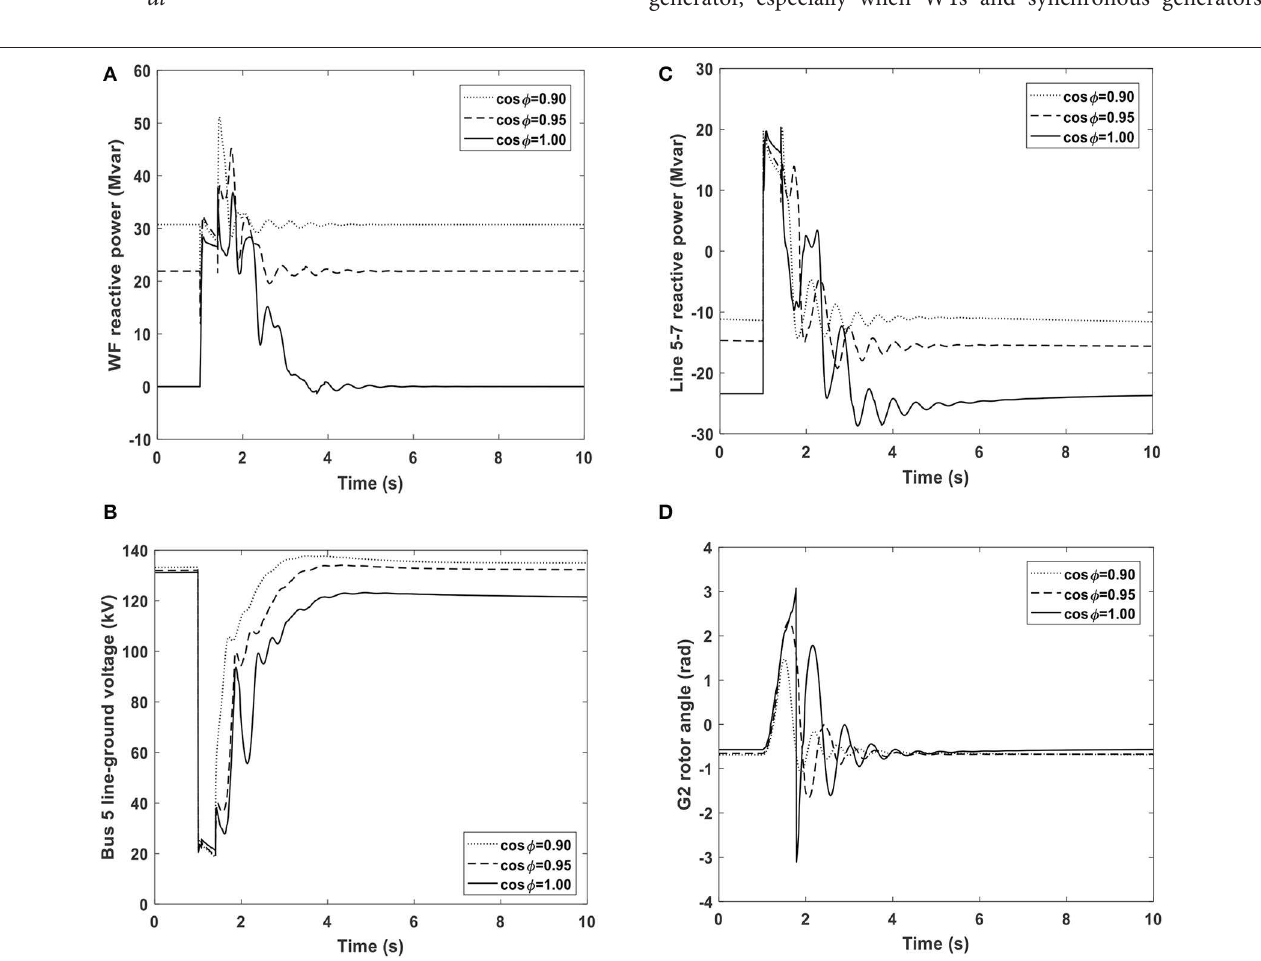
FIGURE 3 | The influence of wind farm on rotor angle stability of G2. (A) Reactive power output of the wind farm. (B) Evolution of voltage magnitude at Bus 5. (C) Modification of reactive power transfer in line 5–7. (D) Collateral effect on the time response of the rotor angle of G2.